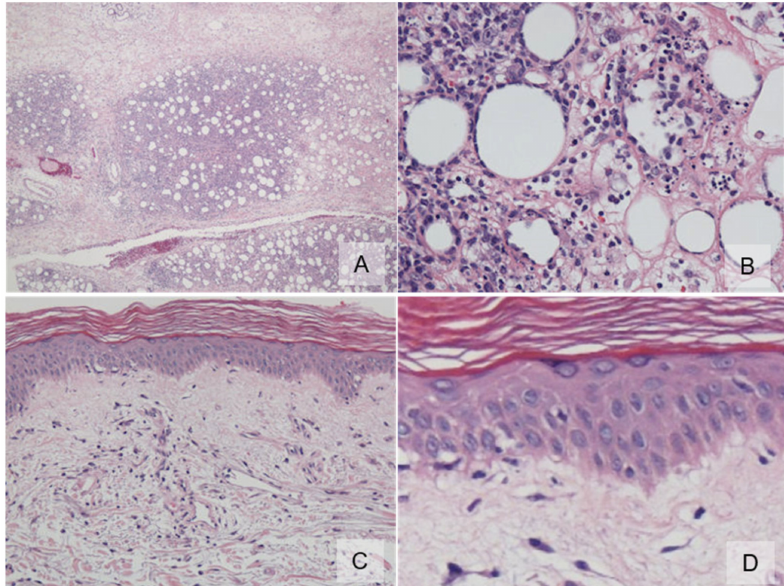
Figure 2. Histopathology. ( A ) An inflammatory infiltrate was found exclusively in the subcutis with a lobular pattern ( × 100); ( B ) subcutis lobule displays individual fat cells rimmed by neoplastic mononuclear cells, fat necrosis, and karyorrhexis ( × 400); ( C ) the overlying epidermis showed